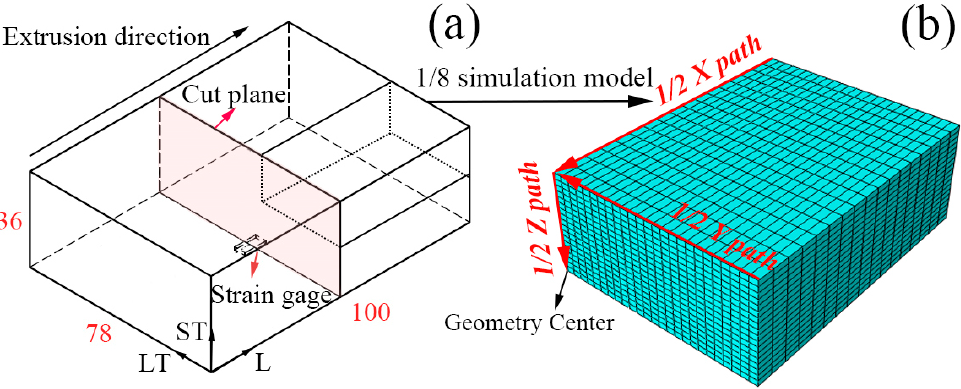
Figure 3. ( a ) Schematic view of crack-compliance method; ( b ) Mesh result and investigated paths.